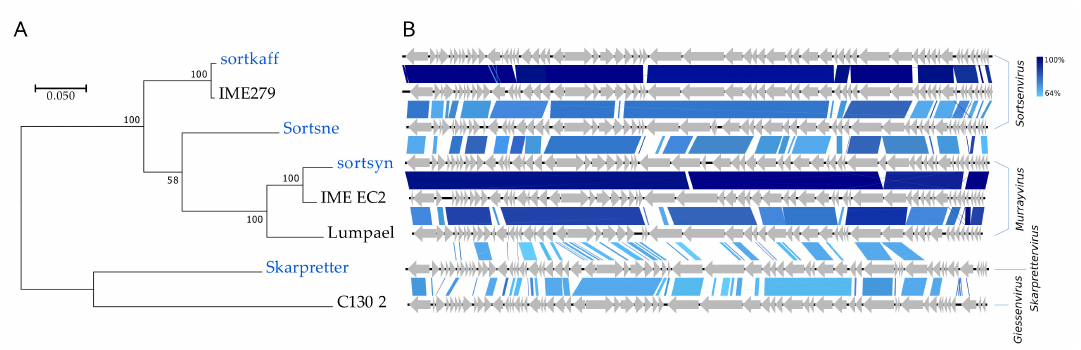
Figure 8. Comparisons of the Podoviridae phage species from this study (blue text) with closest relatives (black text). ( A ) Phylogenetic tree, Maximum log Likelihood: − 8023.43, bootstrap 100, large terminase subunit TerL , scalebar: substitutions per site. ( B ) Pairwise alignment of phage genomes; color bars between genomes indicate percent pairwise similarity (Easyfig, BlASTn). Genomes have been modified to have similar starting